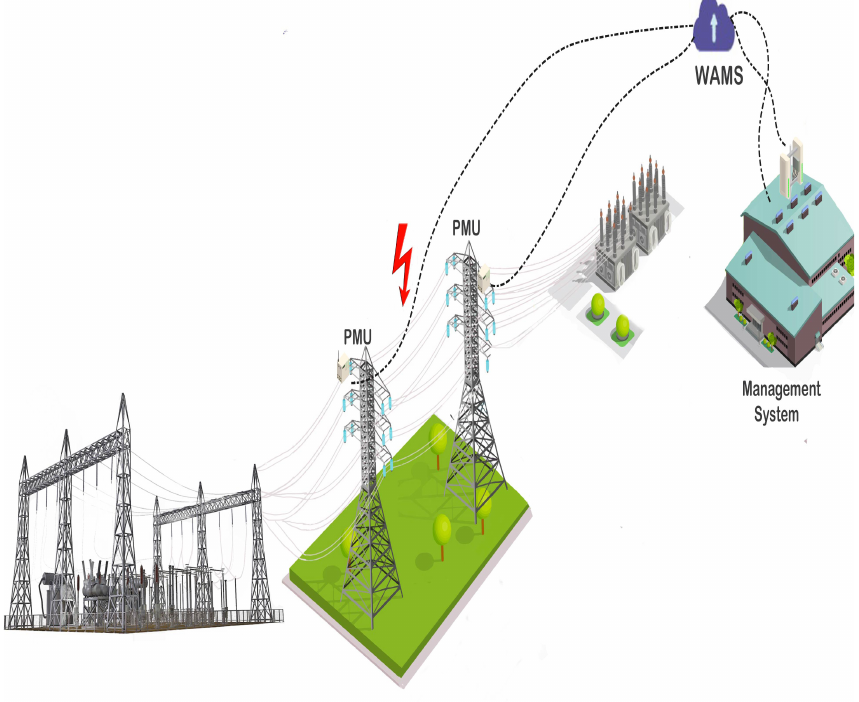
Figure 1. Management and control of the electrical power